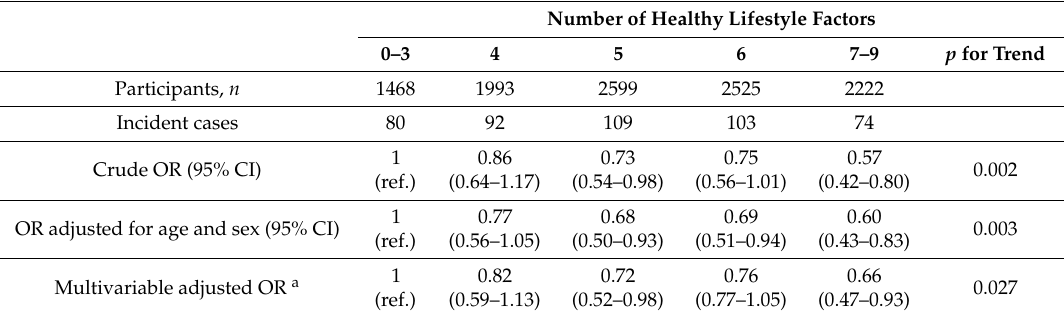
Table 3. Incidence of metabolic syndrome at 6-year follow-up, according to the number of Healthy Lifestyle Score factors (the SUN cohort). OR: Odds ratio; CI: Confidence